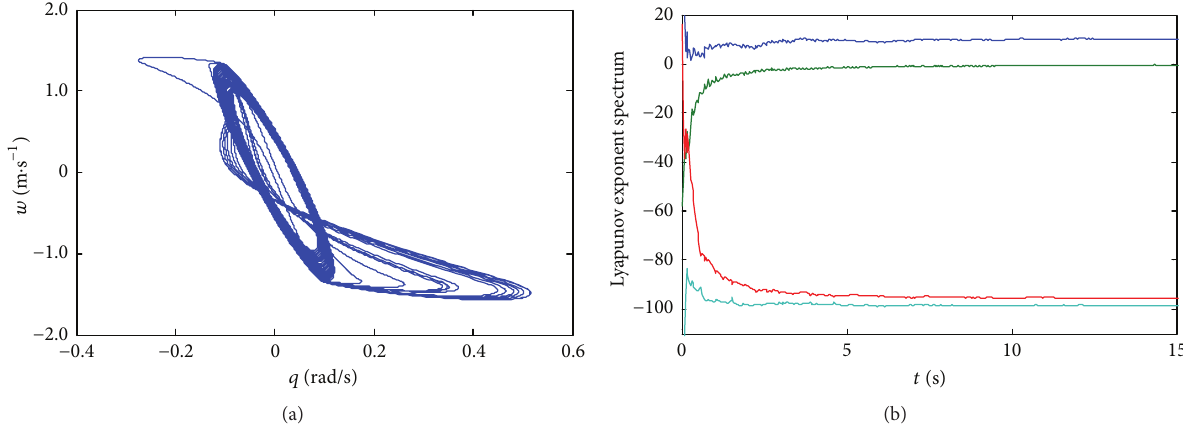
Figure 11: (a) Phase trajectory diagram in 𝑤 − 𝜃 plane when 𝑘 = −55 and (b) Lyapunov exponent